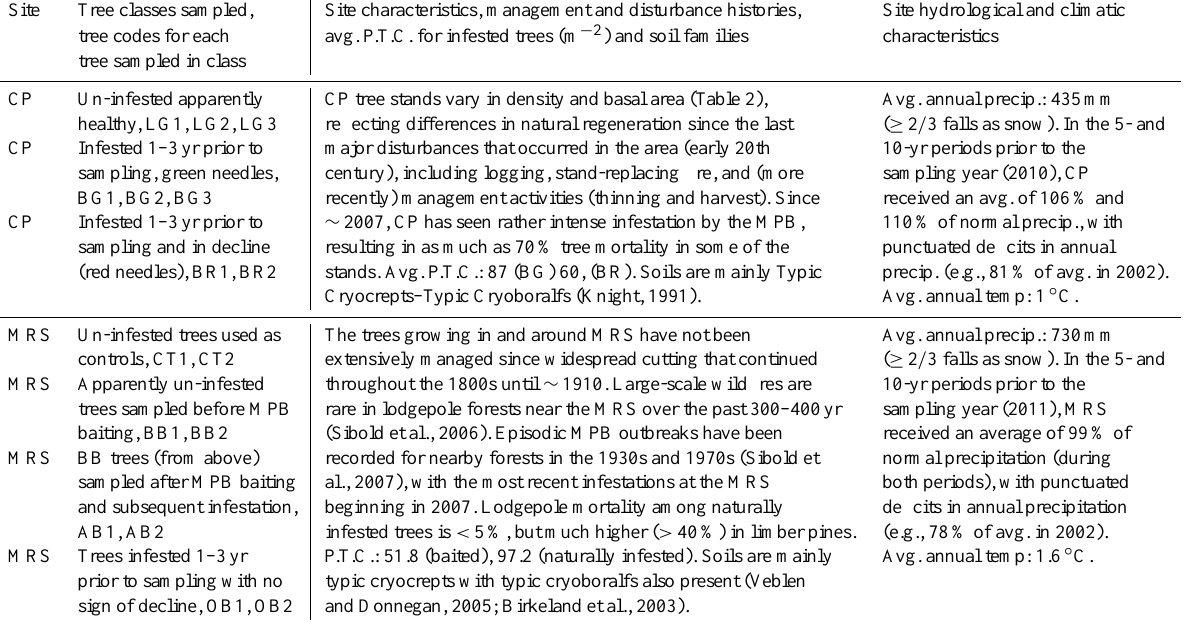
Table 1. Descriptions of trees sampled at CP and MRS, site characteristics, summary of site disturbance and management histories, and hydrological/climatic characteristics of CP and MRS sampling sites. precip. = precipitation; avg. = average; T = temperature, P.T.C. = pitch tube